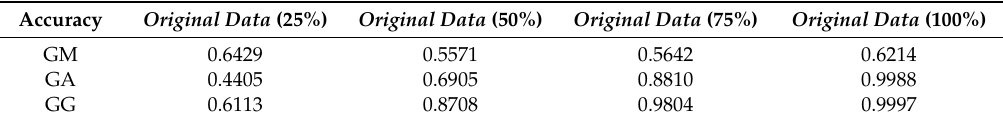
Table 1. The accuracy of RUL prognostics with the amplitude feature.